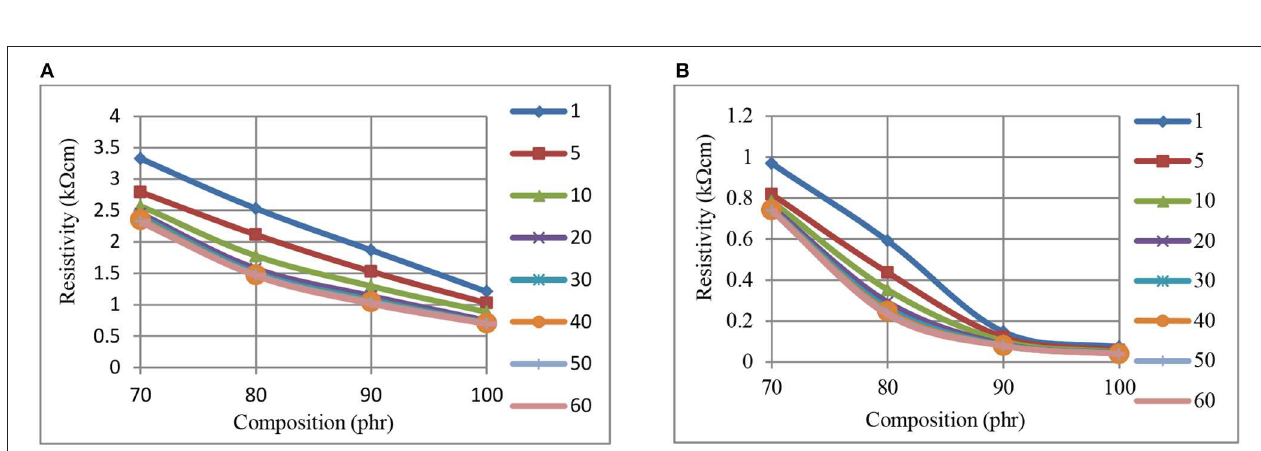
FIGURE 3 | The variation of resistivity, at 0 kPa (A) , and 750 kPa (B) pressure, with composition, for CB-BR composites measured at different times (min, inset right).